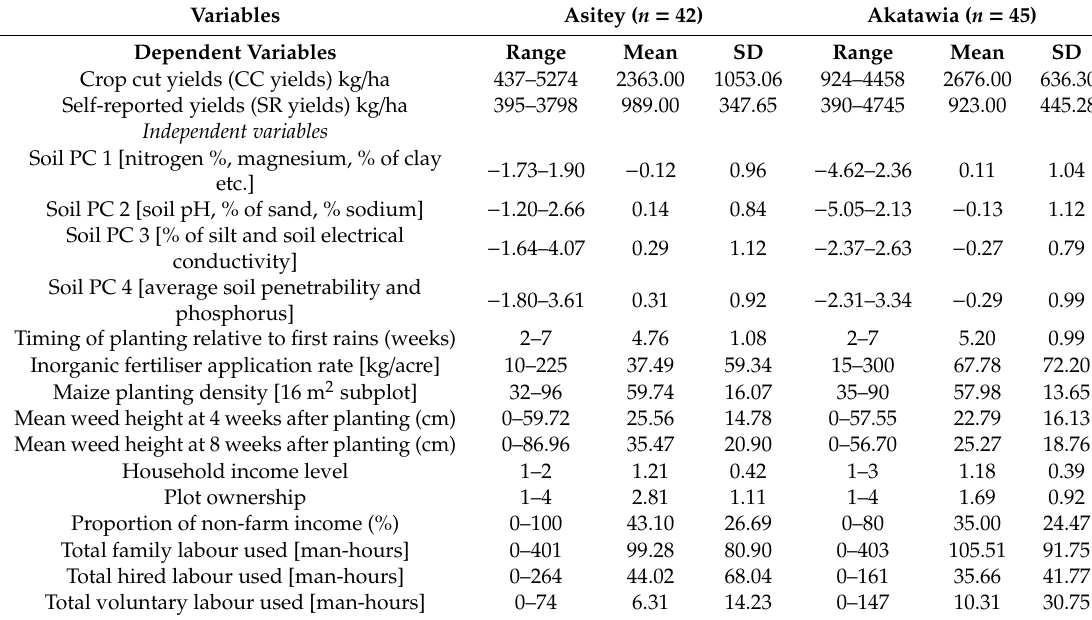
Table 4. Description of variables used for the Multiple Linear